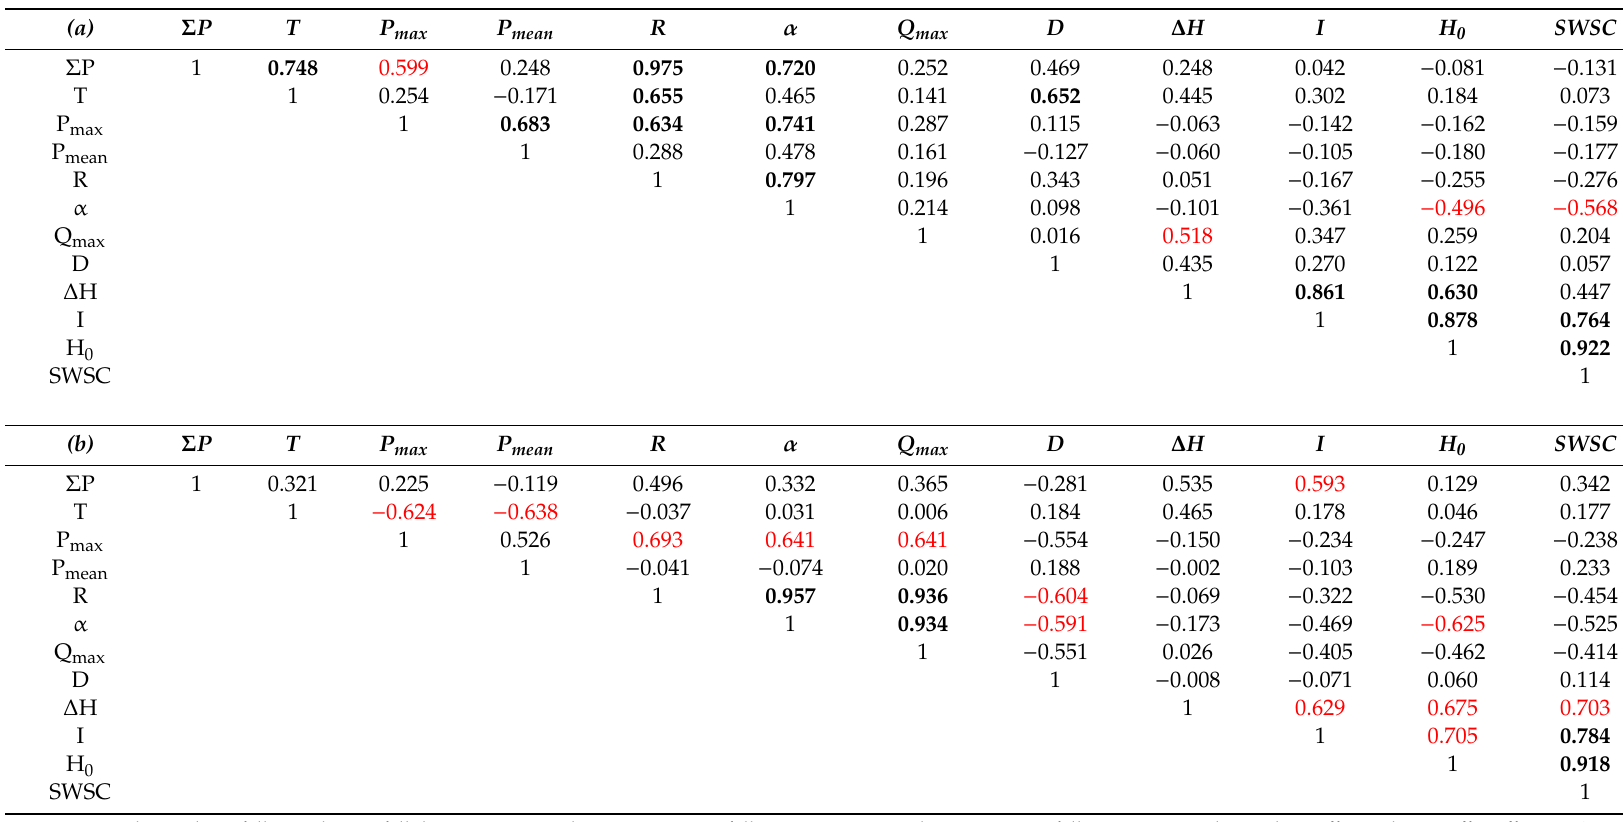
Table 4. Pearson rank correlation matrix of the selected parameters in (a) HQW site and (b) BTQ site. Coe ffi cients in red are significant at the 0.05 level, and values in bold are significant at the 0.01